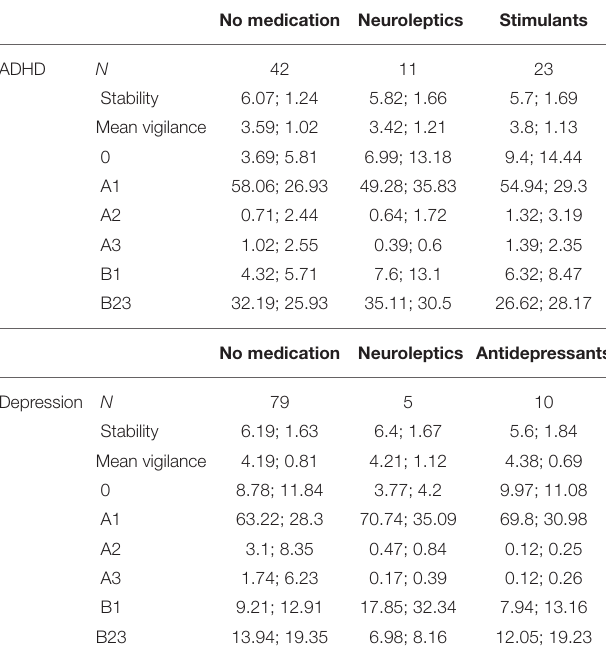
TABLE 7 | Received medication and related EEG